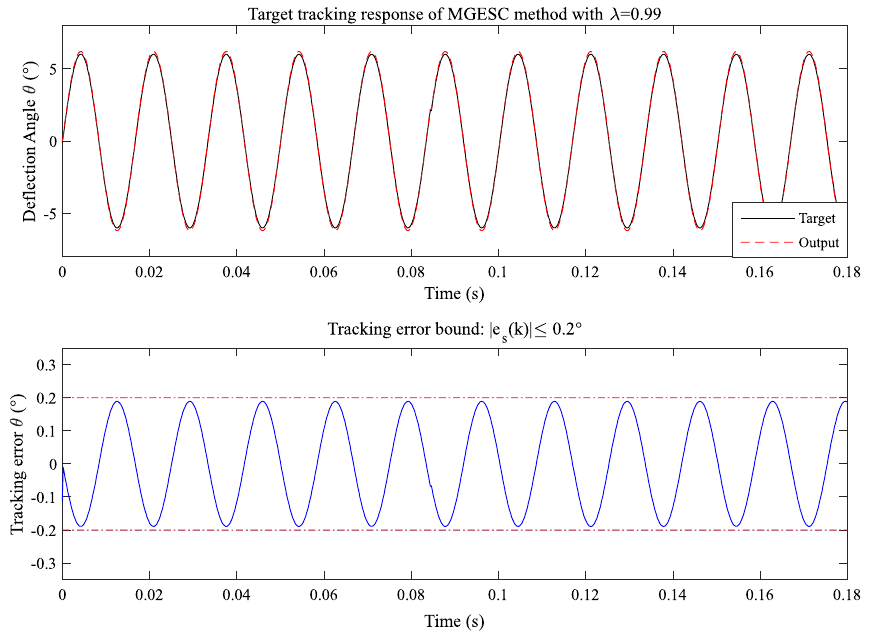
Figure 15. Tracking performance of the MGESC with fixed λ = 0.99.